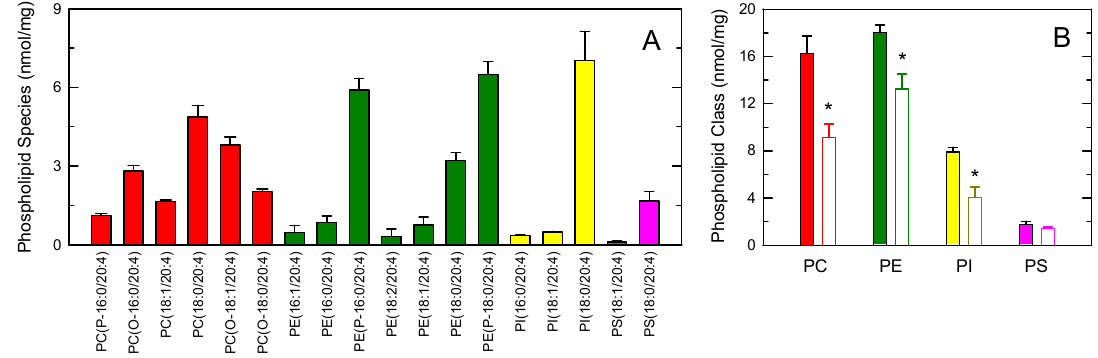
Figure 6. AA-containing phospholipid species in human monocytes. ( A ) The distribution profile of AA between choline-containing phospholipids (PC, red bars), ethanolamine-containing phospholipids (PE, green bars), phosphatidylinositol (PI, yellow bars), and phosphatidylserine (PS, pink bars) species was determined by LC / MS / MS; ( B ) AA content in phospholipids as shown by the class and e ff ect of the cellular stimulation. The cells were not stimulated (colored bars) or stimulated by 1 mg / mL opsonized zymosan for 2 h (open bars). Afterward, the di ff erent phospholipid classes were separated by thin-layer chromatography and their AA content was determined by GC / MS after converting the fatty acid glyceryl esters into fatty acid methyl esters. Data are expressed as means ± SEM of three independent determinations. * p < 0.05, significantly di ff erent from unstimulated